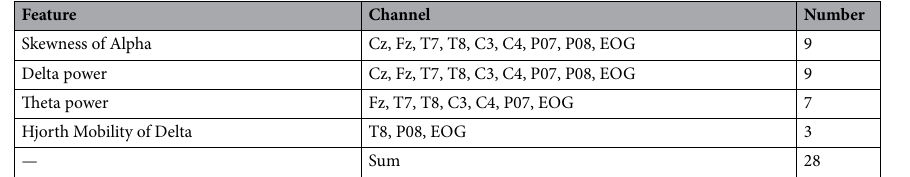
Table 2. EEG features that are consistently significant ( p -value < 0.05 ) across all the 18 studied driving tests. Overall, 28 features are selected by the encoder regardless of driving tests to encode the PERCLOS dynamics. These features include skewness of Alpha (all EEG channels), Delta power (all EEG channels), Theta power (all EEG channels except Cz and P08), Hjorth mobility of Delta (T8, P08, and EOG channels).